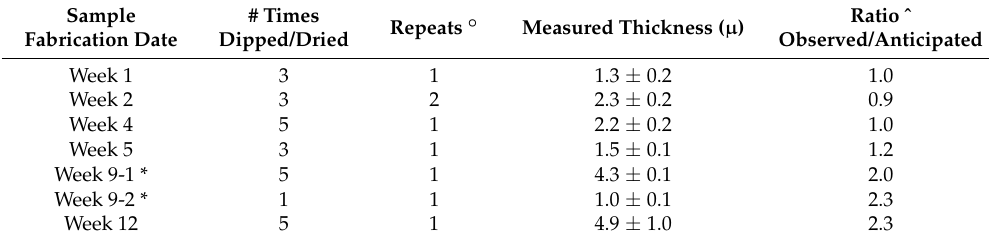
Table 1. Polished cross-section measures of metallic Cr layer